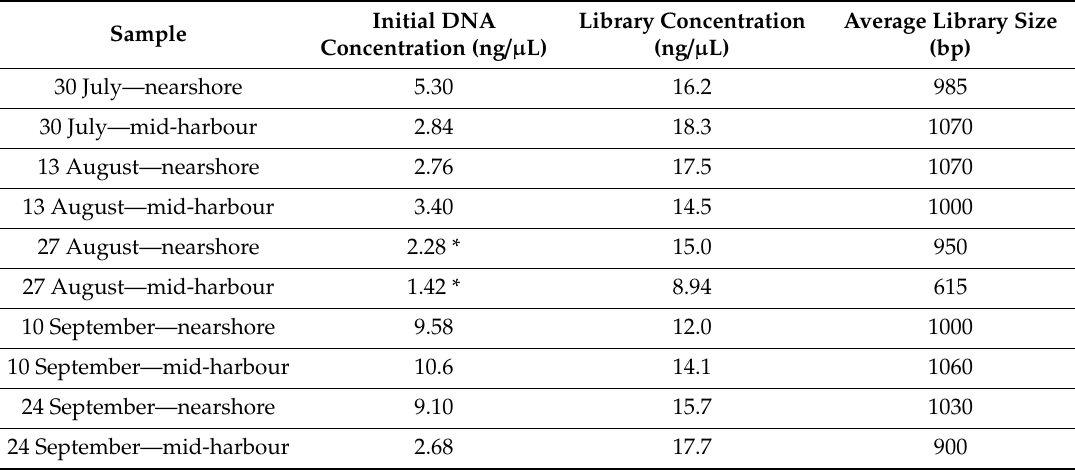
Table 1. Initial DNA concentration, final library concentration, and average fragment size in the library for each of the 10 samples in this study. Initial DNA Library Sample Concentration (ng / µ L)